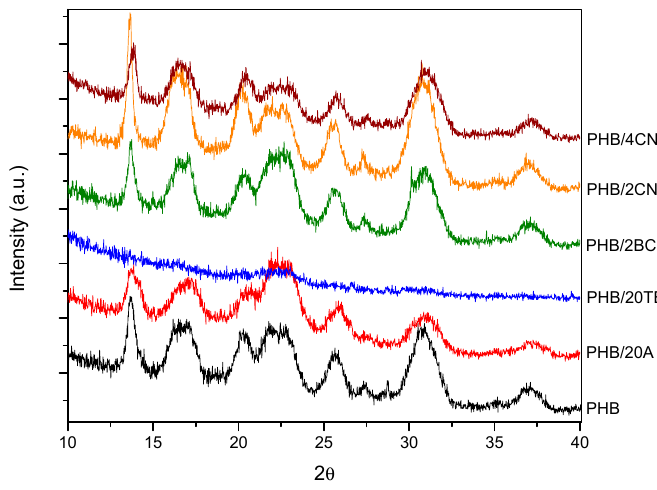
Figure 11. XRD spectra of PHB and binary samples with 14 days under compost conditions.